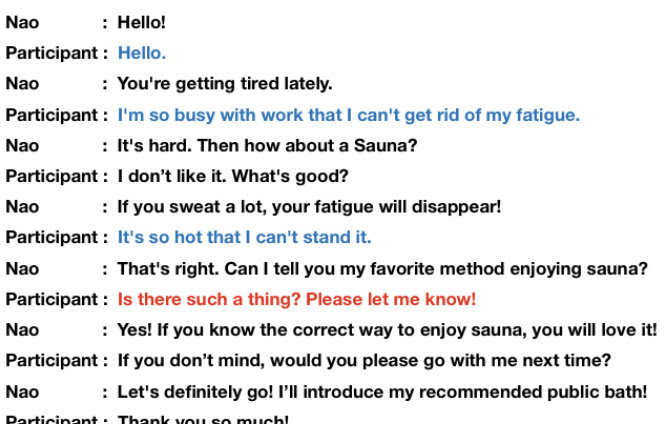
Figure A1. Content regarding the topic of movie invitation in scenario set 1.